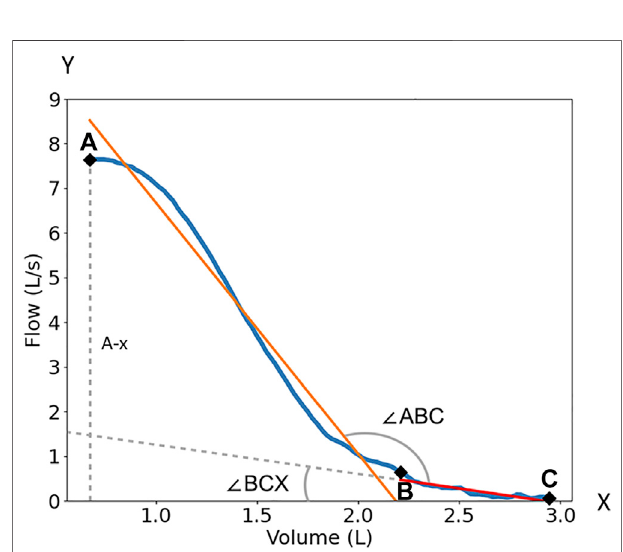
FIGURE 2 | The quanti fi cation of the FVL. Point A is the peak expiratory fl owofthe fl owvolumeloop;PointBisthe75%pointofthemaximumvolume; Point C is the end of the curve. ∠ ABC is the angle between the linear fi tting of AB and BC. ∠ BCX) is the angle between the linear fi tting of BC and x -axis. BC/A-x is the ratio of the BC slope over peak fl ow or the vertical distance (dash line) between A and x -axis (A-x). The orange line is the linear fi tting of the AB segment. The redline with dash line extension is the linear fi tting of the BC segment.